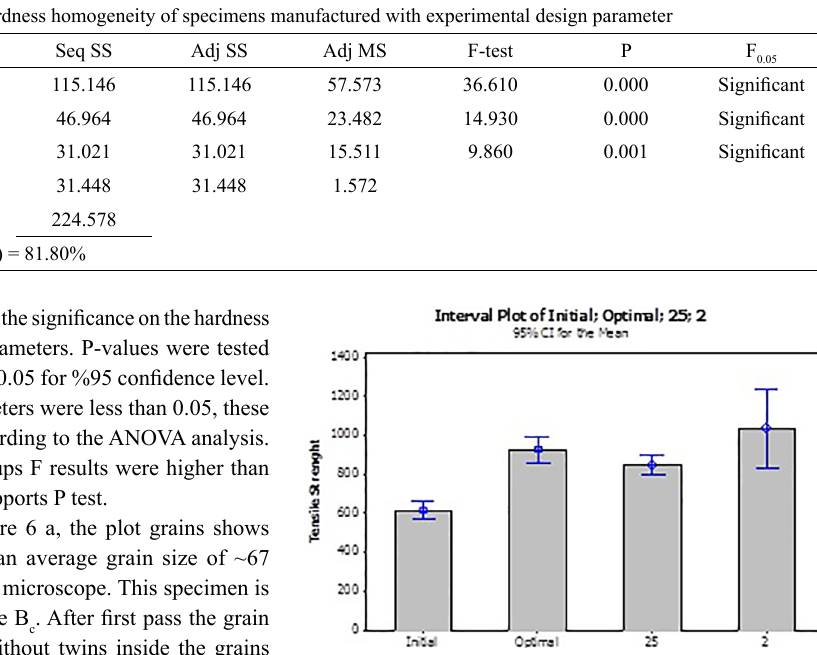
Figure 6. The microstructure of pure Ti (a) in as-received condition, (b) after 1 passes of ECAP processing, (b) 2 pass c) 3 pass (d) 4 pass e) 5 pass (f) 6 pass and (g) 7 pass (h) 8 pass of ECAP pressing at 450 ˚C ultimate tensile strength. As can been seen maximum tensile strength was increased with the ECAP pass number. This result is accordance with Hall-Patch equation. Besides this both 8 pass specimens; optimal, run 25 and Run 2 have different maximum tensile strengths. As given in Figure 7 experimental design run 2 had the highest tensile